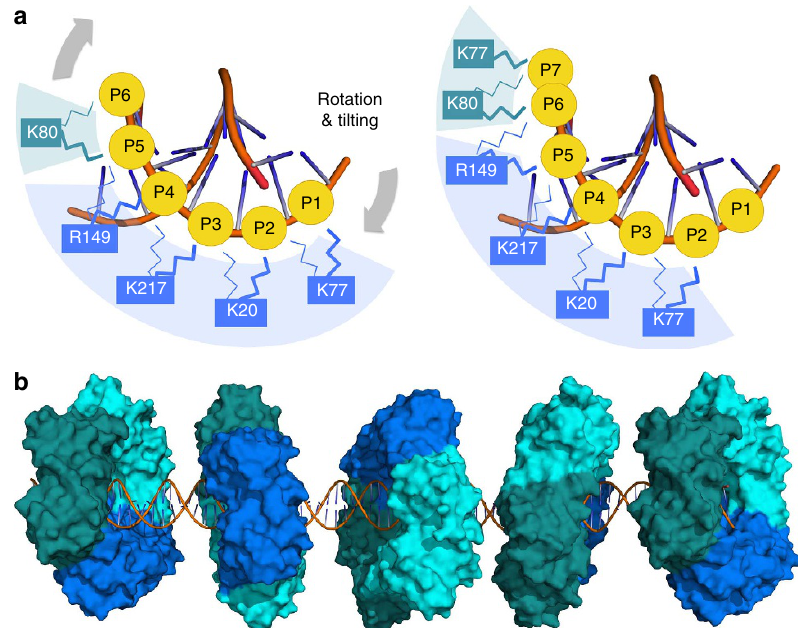
Figure 3 | Proposed ‘cogwheel’ mechanism for PCNA sliding. ( a ) Interacting side chains are able to rapidly switch between adjacent phosphates in a non- coordinated manner (illustrated by the thin and thick lines). When this stochastic process generates a state in which a sufficient number of electrostatic contacts are simultaneously established with adjacent phosphates in one direction of the DNA helical axis, a net rotation of the protein occurs and results in the advancement of one base pair ( b ) PCNA bi-directional tracking of the DNA backbone, which agrees with the clamp helical sliding mode inferred from diffusion data measured by single-molecule imaging 5 . The diffusion coefficient of PCNA (1.16 m m 2 s (cid:2) 1 ) implies that, on average, PCNA diffuses 8bp per